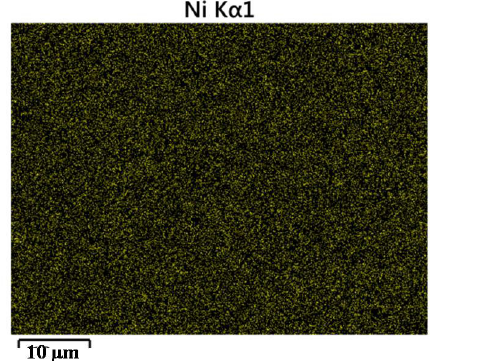
Figure 10. Surface scan of FeCrMnNi alloy after corrosion in 360 °C high temperature and high pressure water environment for 14 days.